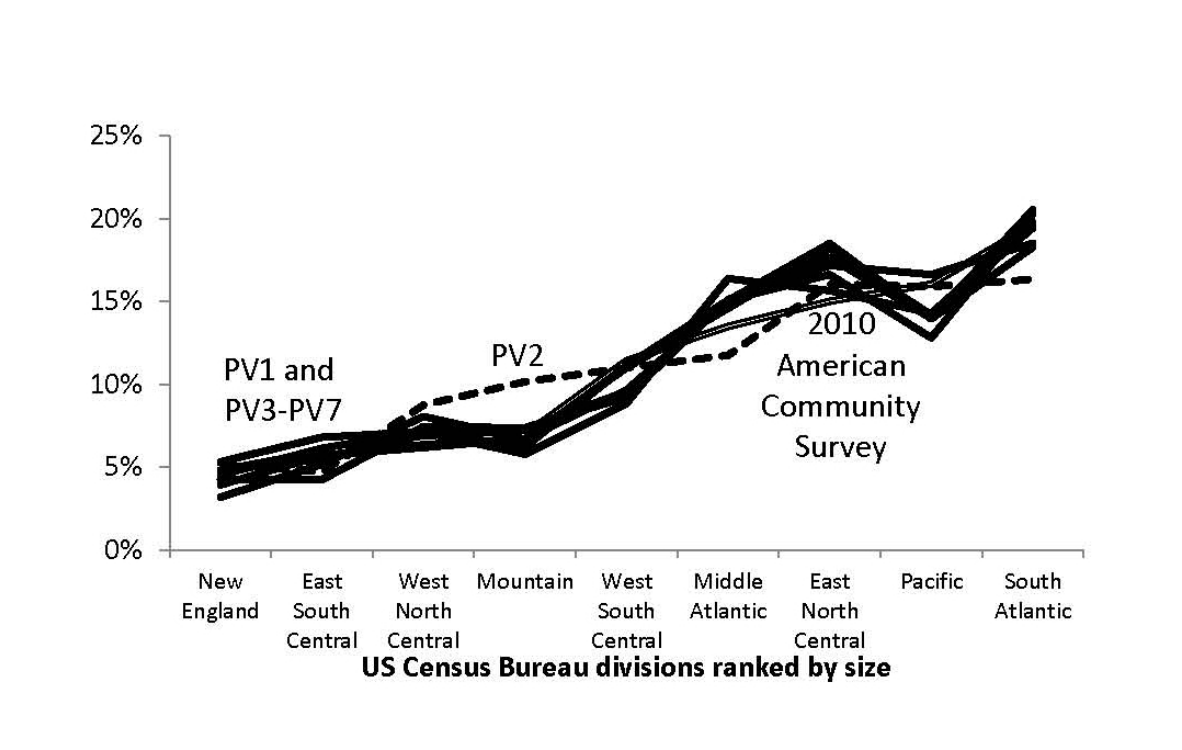
Figure 6. Weighted proportion of respondents who passed screener by US Census division and panel vendor